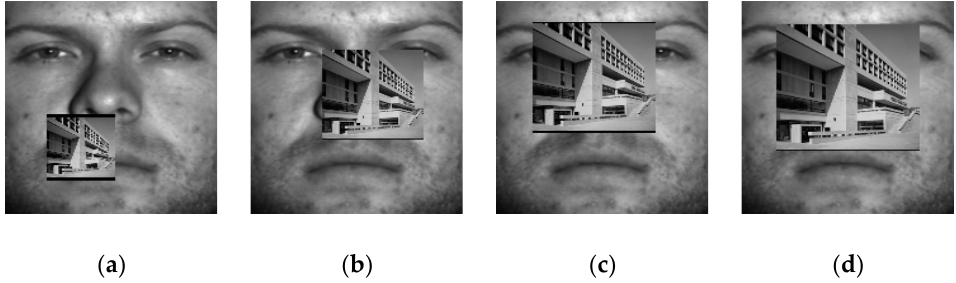
Figure 13. Occlusion maps of different proportions used with the test samples: ( a ) face image with an occlusion ratio of 10%; ( b ) face image with an occlusion ratio of 20%; ( c ) face image with an occlusion ratio of 30%; ( d ) face image with an occlusion ratio of 40% [ Reprinted with permission from Elsevier [20]. Copyright 2013, Neurocomputing ] .